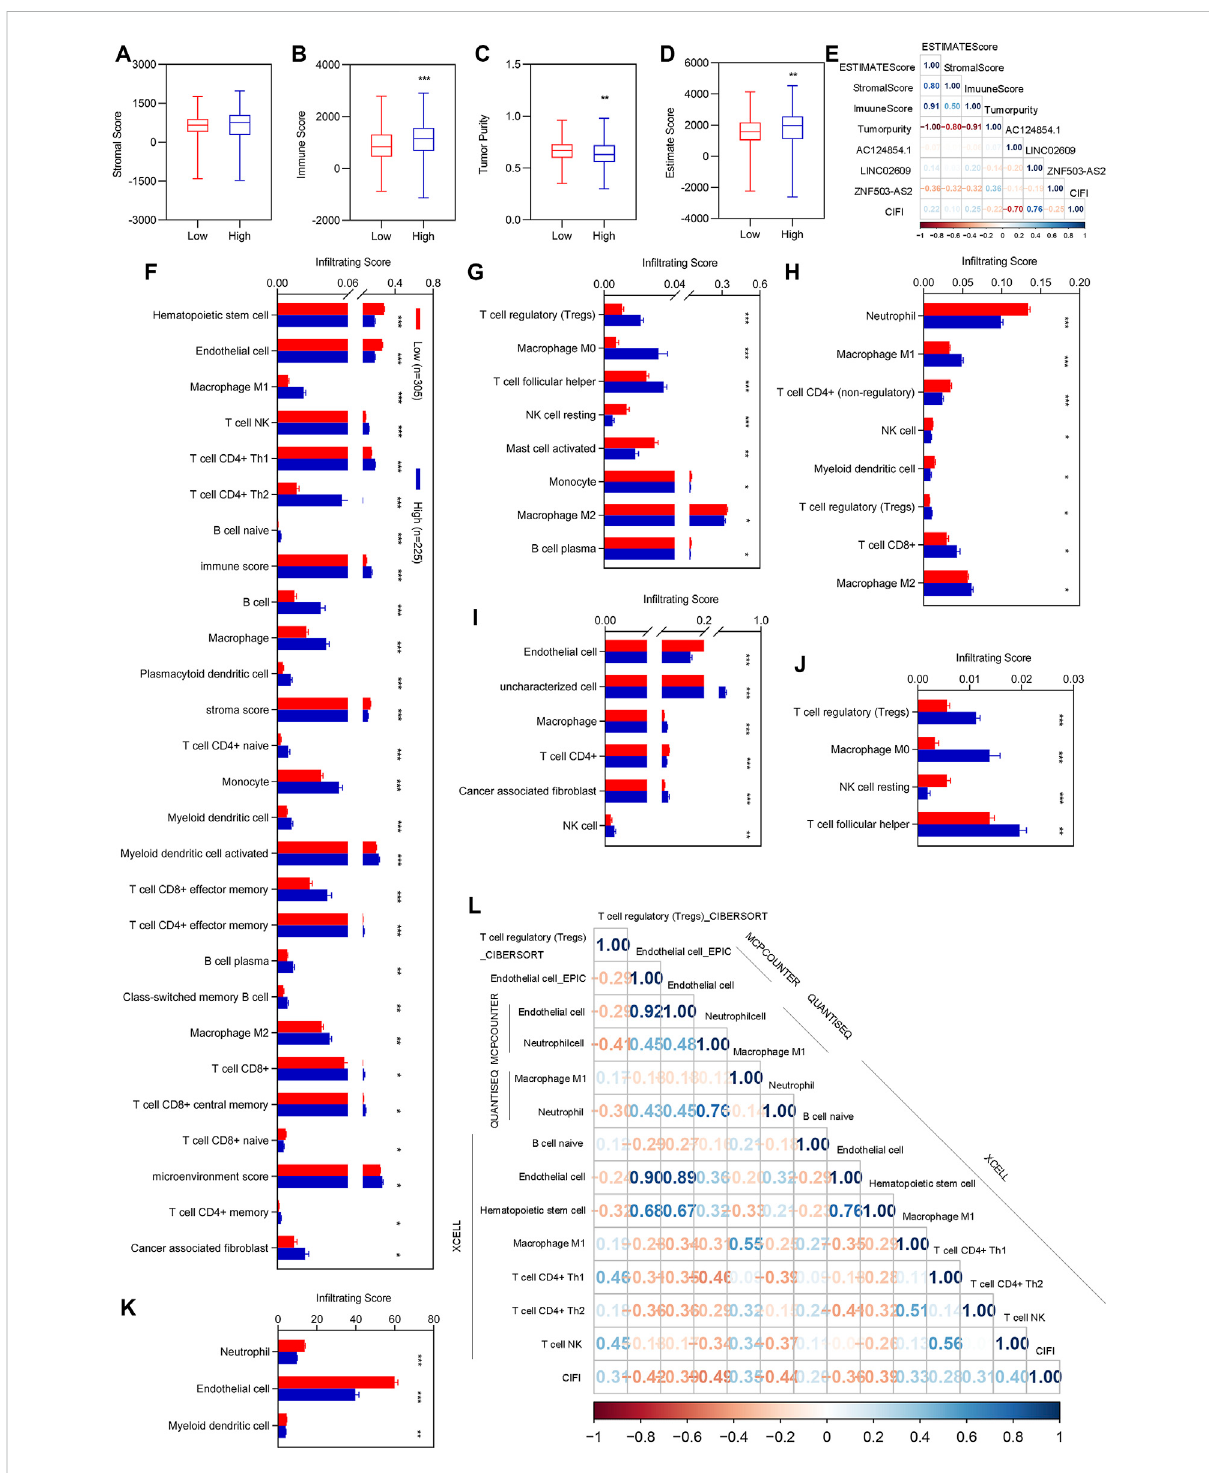
FIGURE 4 Correlation analysis of CIFI with the ESTIMATE score and immune in fi ltration. (A – D) Immune score between patients with KIRC with low CIFI valueandpatients withKIRCwith highCIFI value. (A) Stromalscore. (B) Immunescore. (C) Tumorpurity. (D) ESTIMATEscore. (E) Correlationanalysis of the three FI-DELs with the ESTIMATA Score. (F – K) Differentially expression analysis of the in fi ltrating score between patients with KIRC with low CIFI value and patients with KIRC with high CIFI value. (F) XCELL. (G) CIBERSORT. (H) quanTIseq. (I) EPIC. (J) CIBERSORT-ABS. (K) MCPCOUNTER. (H) Signi fi cantly associated immune cells and factors with CIFI. Correlation analysis of the prognostic model with the immune cells and factors. * p < 0.05, ** p < 0.01, *** p <